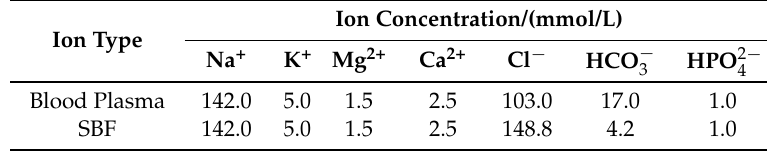
Table 1. Ion concentration in SBF and human blood